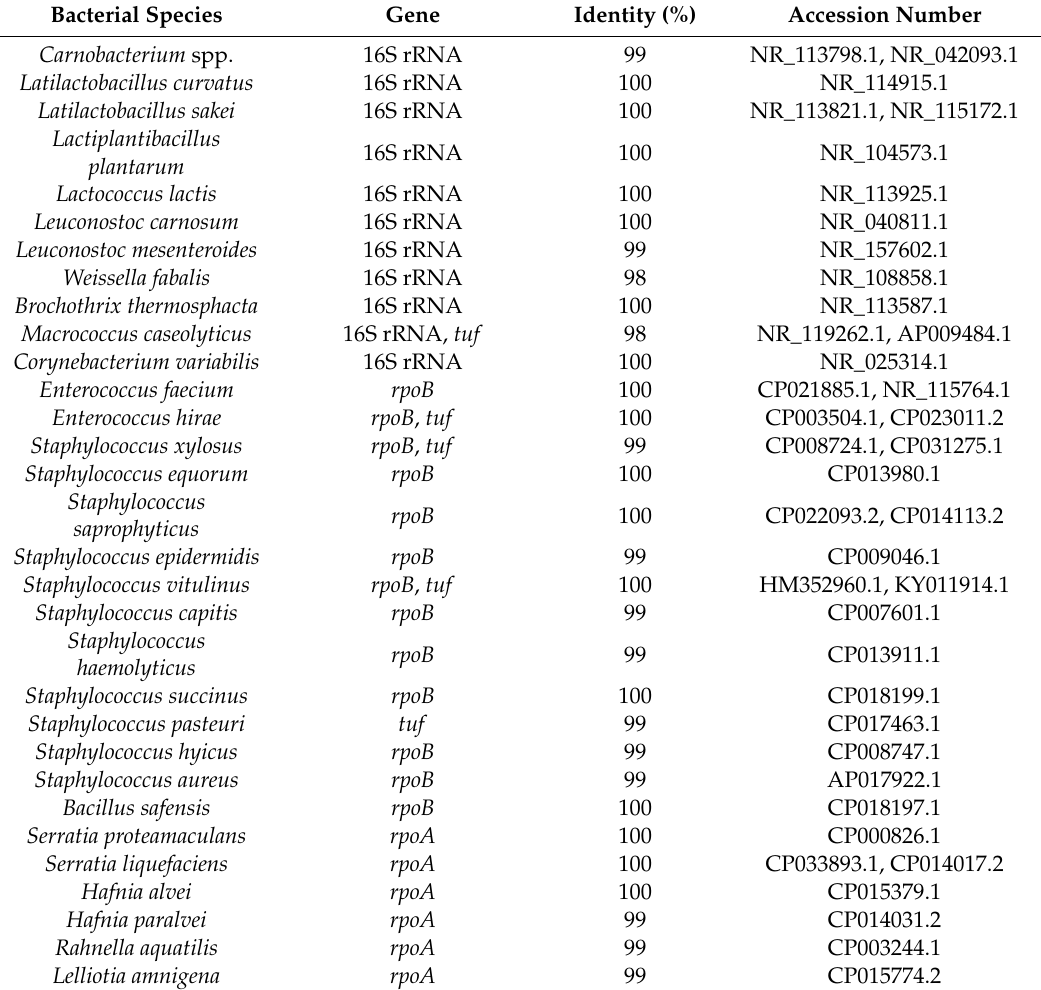
Table 2. Identities of the 16S rRNA, and / or rpoB , tuf , and rpoA genes sequenced from genomic DNA of representative bacterial isolates picked from MRS agar, MSA, and RAPID’Entero agar, and the accession numbers of the entries with the highest